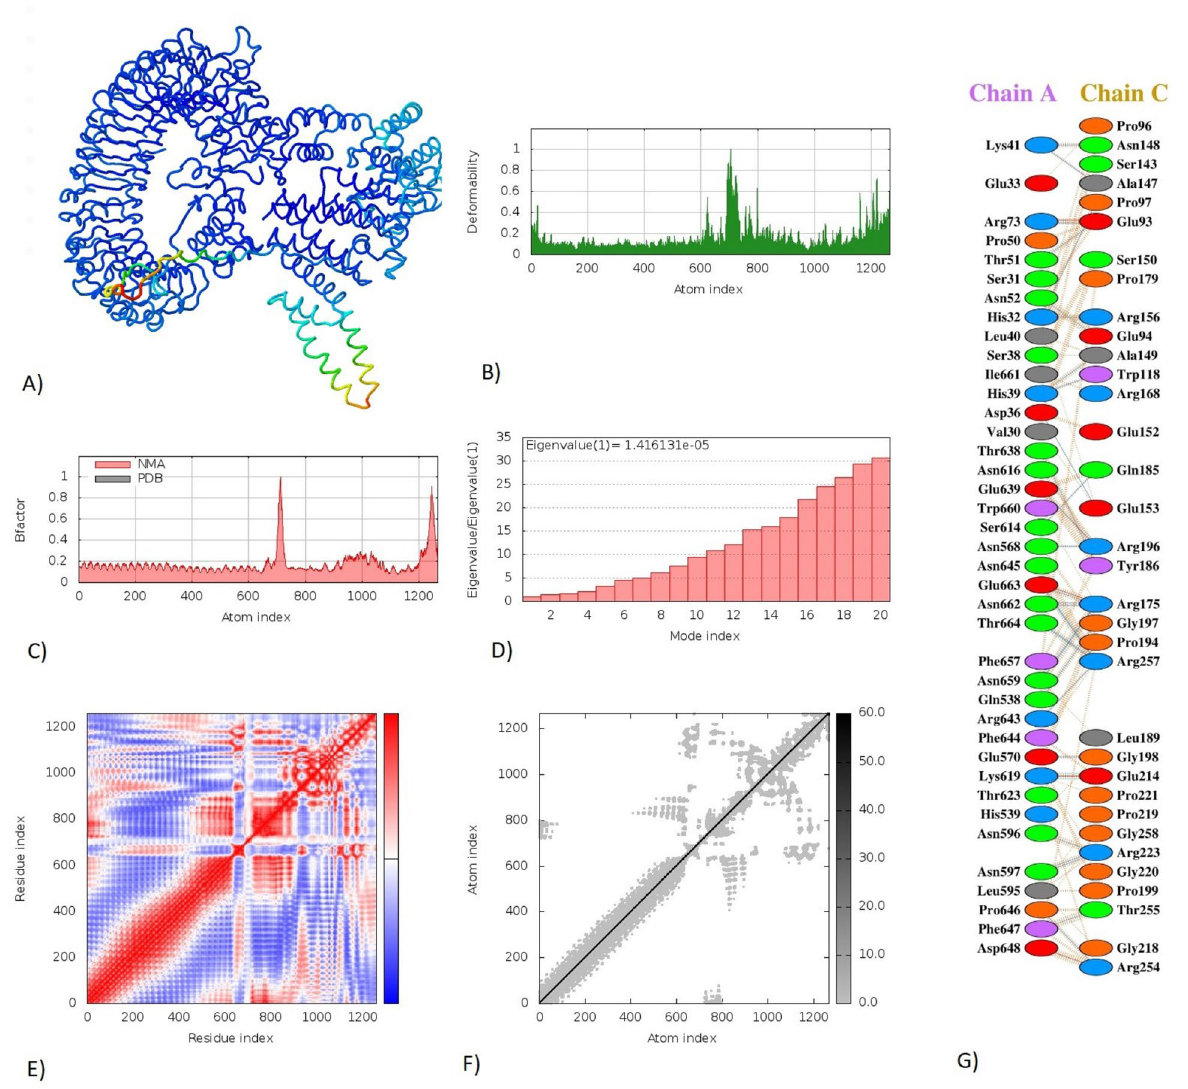
Figure 8. Molecular dynamics simulation, Normal Mode Analysis, and receptor-ligand interactions: ( A ) Vaccine-TLR3 docked complex using the Cluspro server ( B ) Deformability graph ( C ) B-factor graph ( D ) Eigenvalue of vaccine-TLR3 complex ( E ) Covariance matrix ( F ) Elasticnetwork model using the iMODS server ( G ) Receptor-ligand interaction using the PDBsum